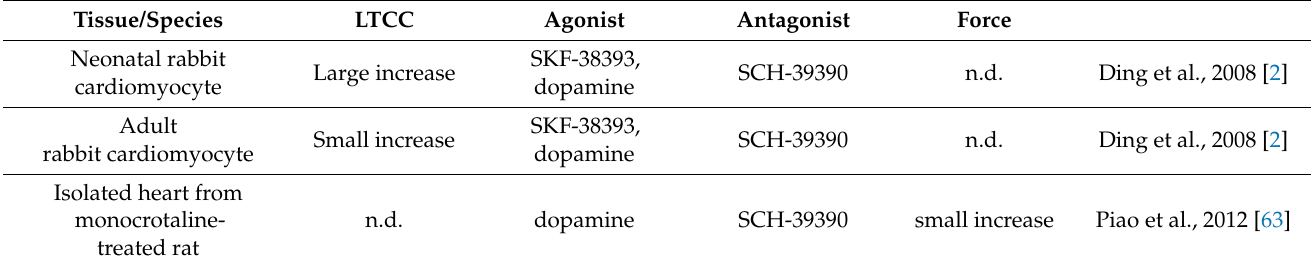
Table 3. Species-dependent functional actions of dopamine via dopamine receptors on myocardial tissue. Here, the meagre evidence is assembled where dopamine not exclusively but measurably exerts functional cardiac effects via dopamine receptors. Abbreviations: LTCC: L-type calcium ion current. Moreover, we mention which agonist or antagonist for dopamine receptors was used to reach a conclusion. Please see Table 1A,B for the appropriateness of the drugs used in these studies.